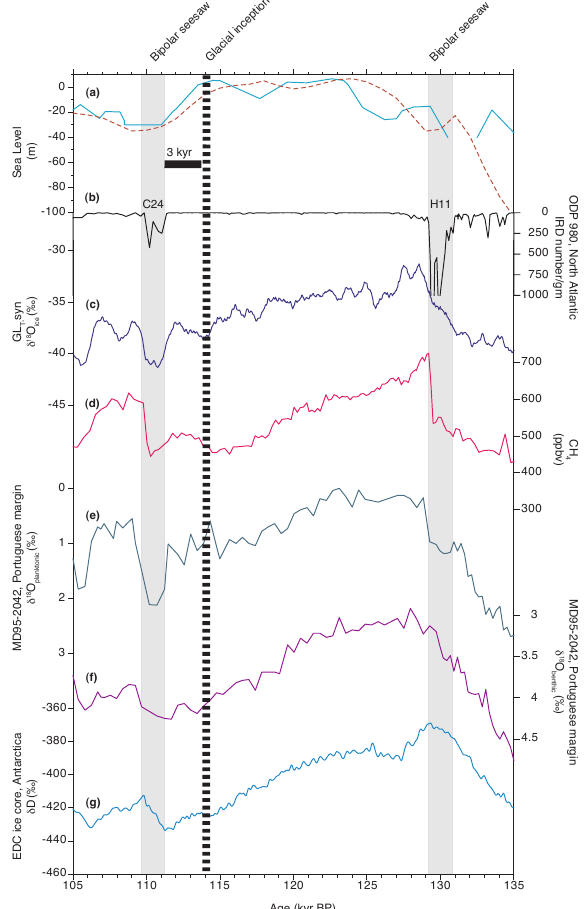
Fig. 2. Last Interglacial palaeoclimate records. (a) sea-level recon- structions by Thompson and Goldstein (2006) (continuous line) and Kopp et al. (2009) (dashed line); (b) ice rafted detritus (IRD) abundance data in Site OPD 980 in the North Atlantic (Oppo et al., 2006); (c) reconstructed δ 18 O composition of ice in Green- land synthetic (GL T − syn) record; timescale based on alignment to Chinese speleothem records (Barker et al., 2011); (d) atmo- spheric CH 4 concentration in the EDC ice core (Loulergue et al., 2008), on the GL T − syn timescale of Barker et al. (2011); (e) δ 18 O composition of planktonic foraminifera in core MD95-2042 on the Portuguese margin (Shackleton et al., 2002); timescale based on alignment of the δ 18 O planktonic record to the GL T − syn record of Barker et al. (2011); (f) δ 18 O composition of benthic foraminifera in core MD95-2042 on the Portuguese margin (Shackleton et al., 2002); timescale as in (e) ; (g) δ D composition of ice in the EDC ice core (Jouzel et al., 2007), on the GL T − syn timescale of Barker et al. (2011). Grey bands denote the position of terminal Heinrich Event 11 (H11) and of cold-water event C24. Thick dashed line shows the estimated timing of the monotonic drop in sea-level on the Thompson and Goldstein (2006)